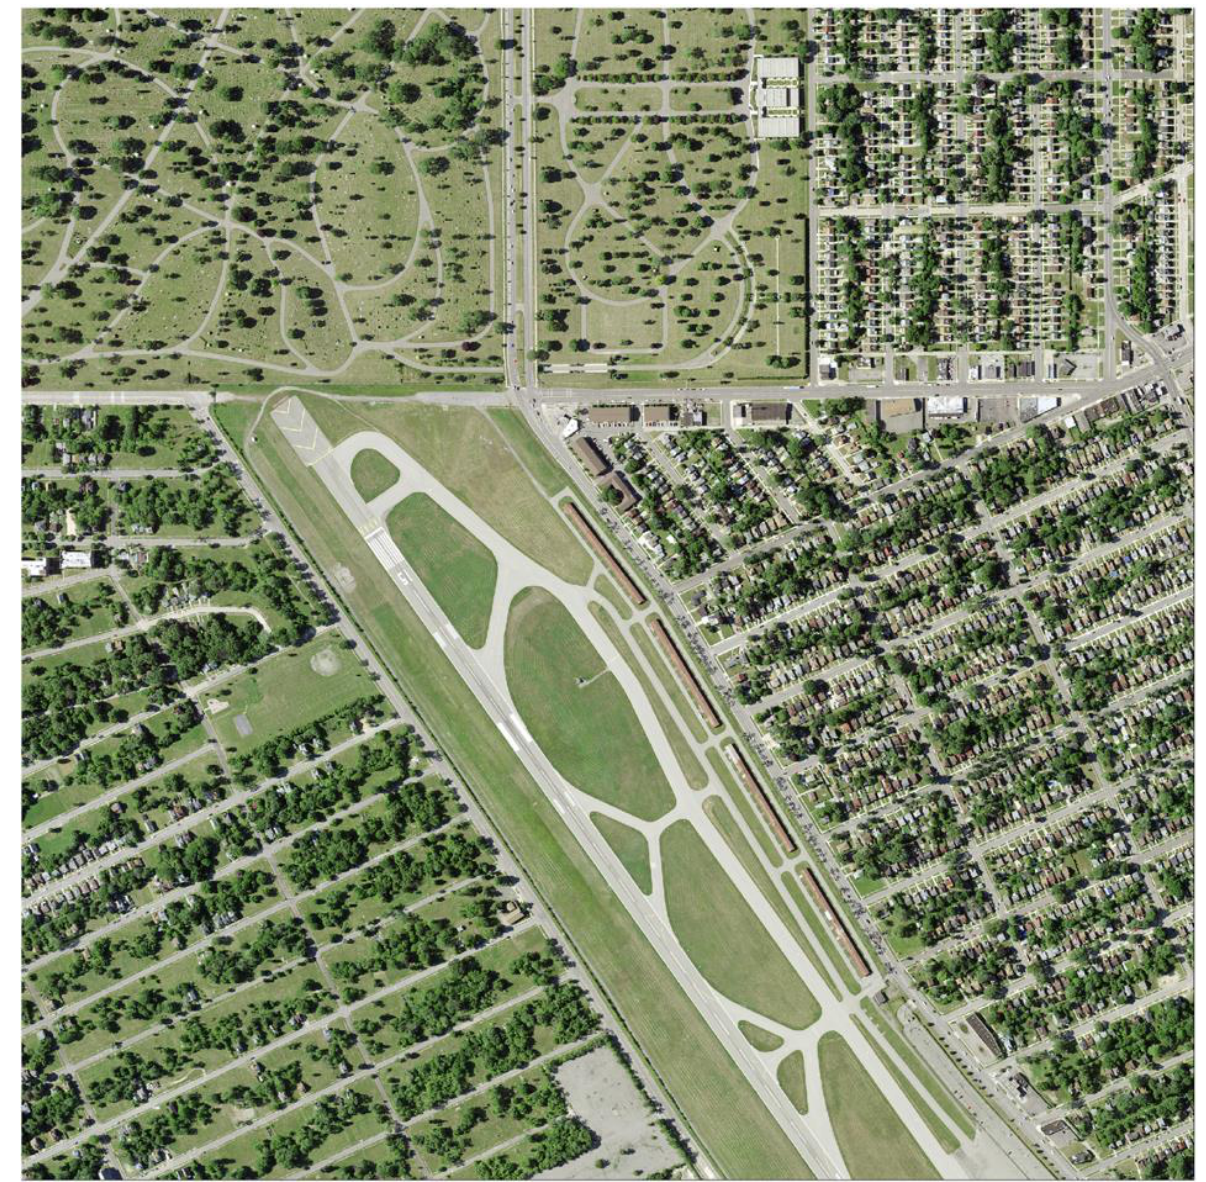
Figure 4. Observed 2.59 square km (one square mile) extent, NAIP 2018.